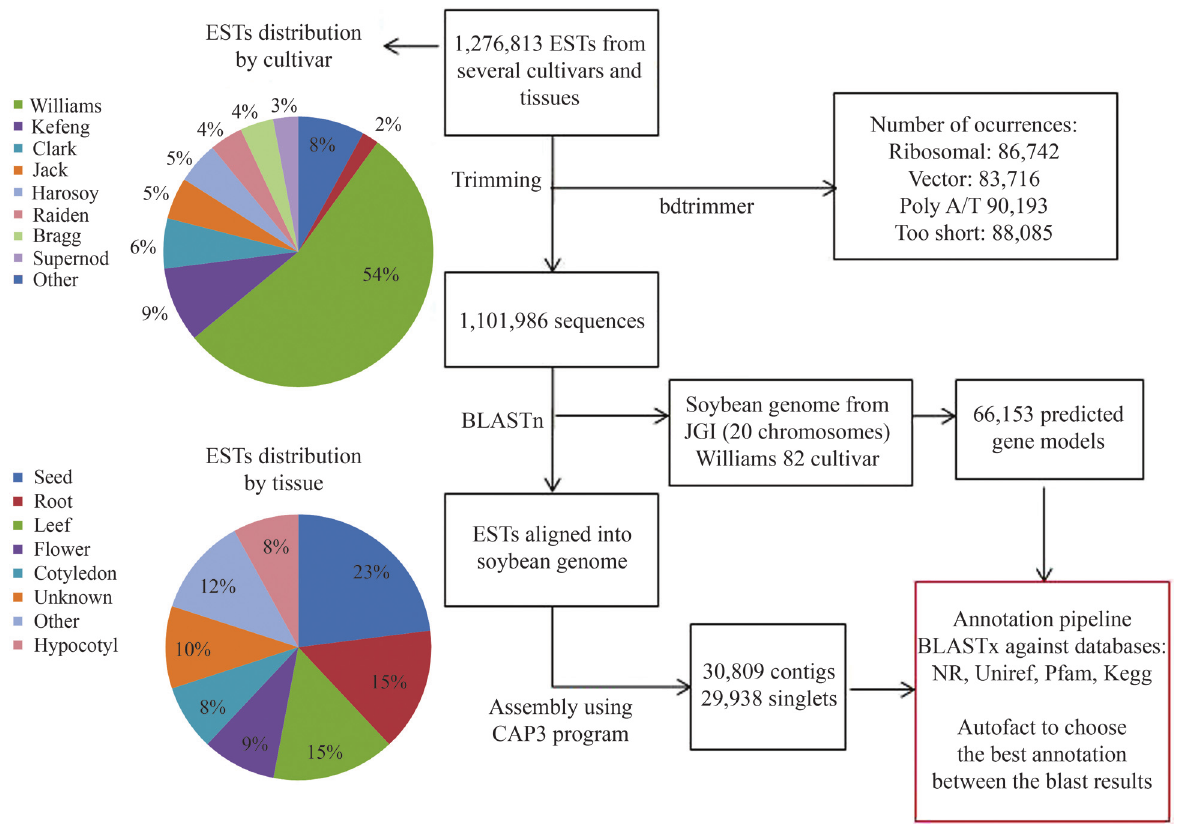
Figure 1 - Complete pipeline of the public soybean data analysis. We found many occurrences of vector and poly A/T sequences in the NCBI ESTs. After trimming, a reference assembly was performed using 1,101,986 sequences. Moreover, the predicted Williams 82 genes (66,153 sequences) and the as-